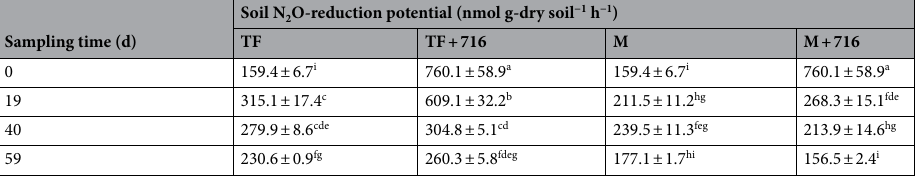
Table 1. Comparison of the soil N 2 O-reduction potential during the rhizoremediation of diesel-contaminated soil. TF: soil planted with tall fescue; TF + 716: soil planted with tall fescue inoculated with strain TF716; M: soil planted with maize; M + 716: soil planted with maize inoculated with strain TF716. Different letters indicate significant differences between treatments ( p < 0.05).